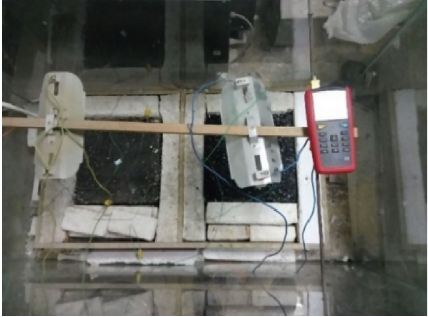
Figure 4: Photograph of the test